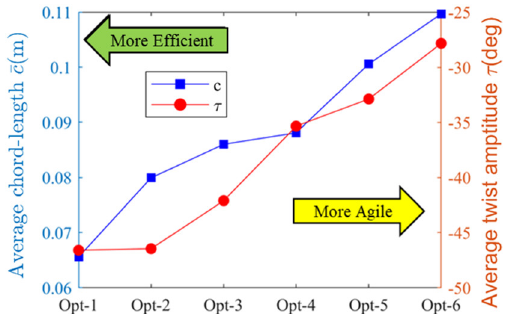
Figure 19. Average relative blade width and average twist amplitude of different optimal VPPs.